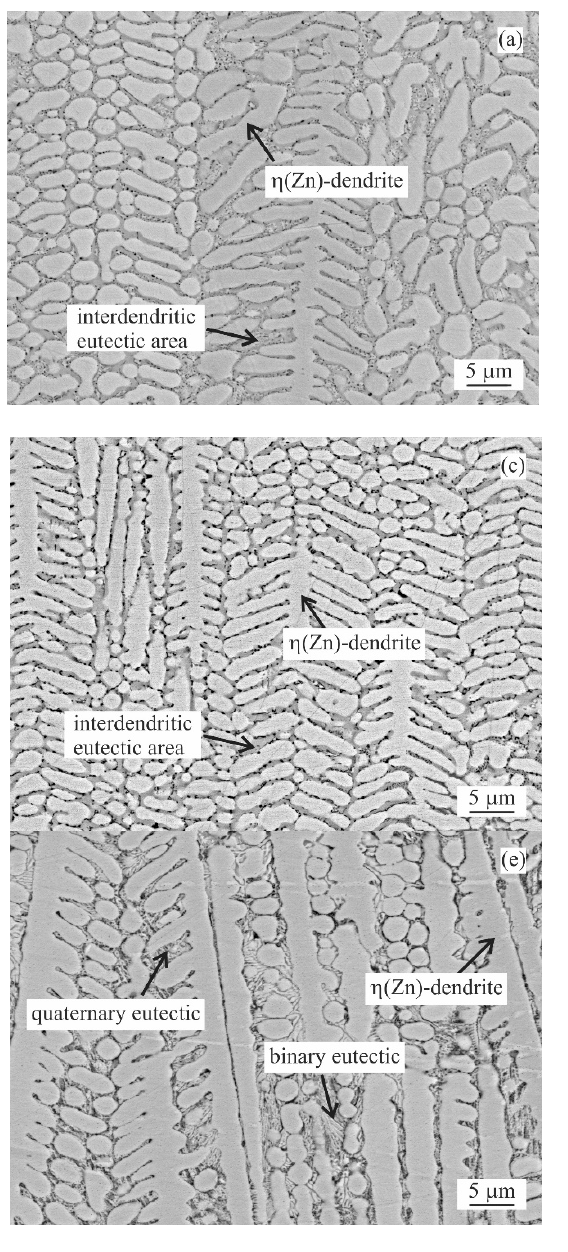
Figure 9. Microstructure images for selected samples, longitudinal section, near sample surface: ( a ) MZ + 0.0Sn as-cast, ( b ) MZ + 0.0Sn annealed, ( c ) MZ + 0.5Sn as-cast, ( d ) MZ + 0.5Sn annealed, ( e ) MZ + 3.0Sn as-cast, ( f ) MZ + 3.0Sn annealed.